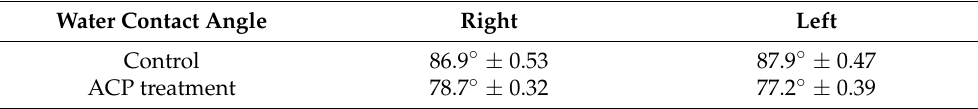
Figure 10. Photos of water contact angle of the control and ACP−treated samples. ( a ) Untreated soy protein film. ( b ) Soy protein film treated at 30 kV for 3 min. Untreated soy protein film was considered as the control. The amount of soy protein was 10% and glycerol was 2.8%. Table 4. Water contact angle of the control and ACP−treated samples. The ACP treatment is soy protein film treated at 3 min, at 30 kV. The control is untreated soy protein film.